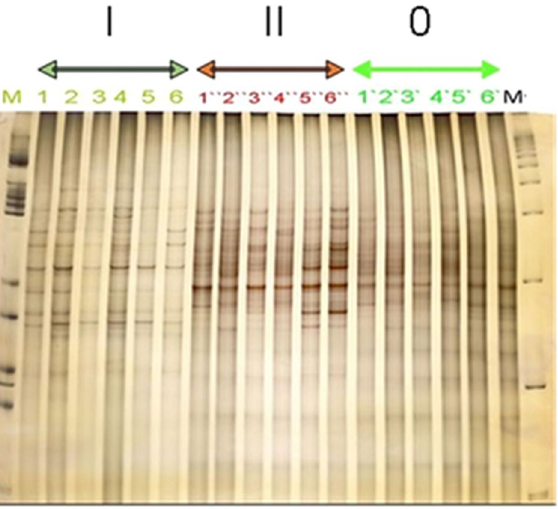
Figure 1. Succession of PCR-amplified products in different contaminated soils from Kafr elzyat- Egypt detected by SSCP on a polyacrylamide gel. PCR primers were designed to amplify the regions of eubacterial 16SrRNA genes from directly extracted soil DNA was used as a template (S, standard DNA) from clean soil (0), slightly PCBs- contaminated soil (I), and highly PCBs- contaminated soil (II).